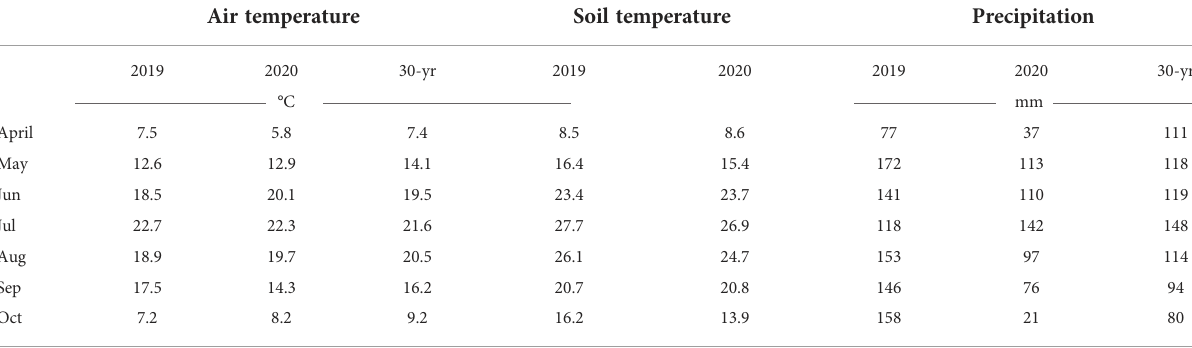
TABLE 2 Monthly average air and soil temperature, and precipitation for the experimental site at Arlington, Wisconsin, and greenhouse air temperatures during the 2019 and 2020 growing seasons. ab . Air temperature Soil temperature